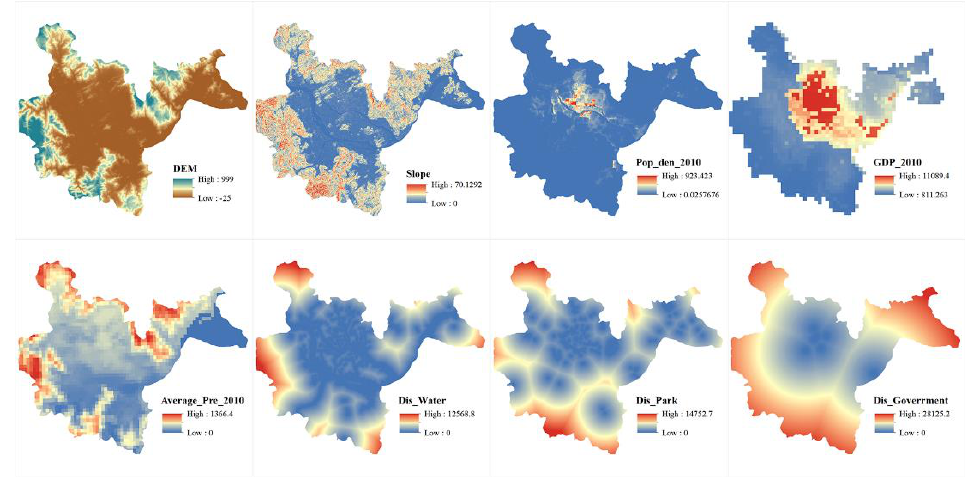
Figure A1. Driving factors for 2010. Table A1. Landsat image series data of Fuzhou from 2000 to 2020.